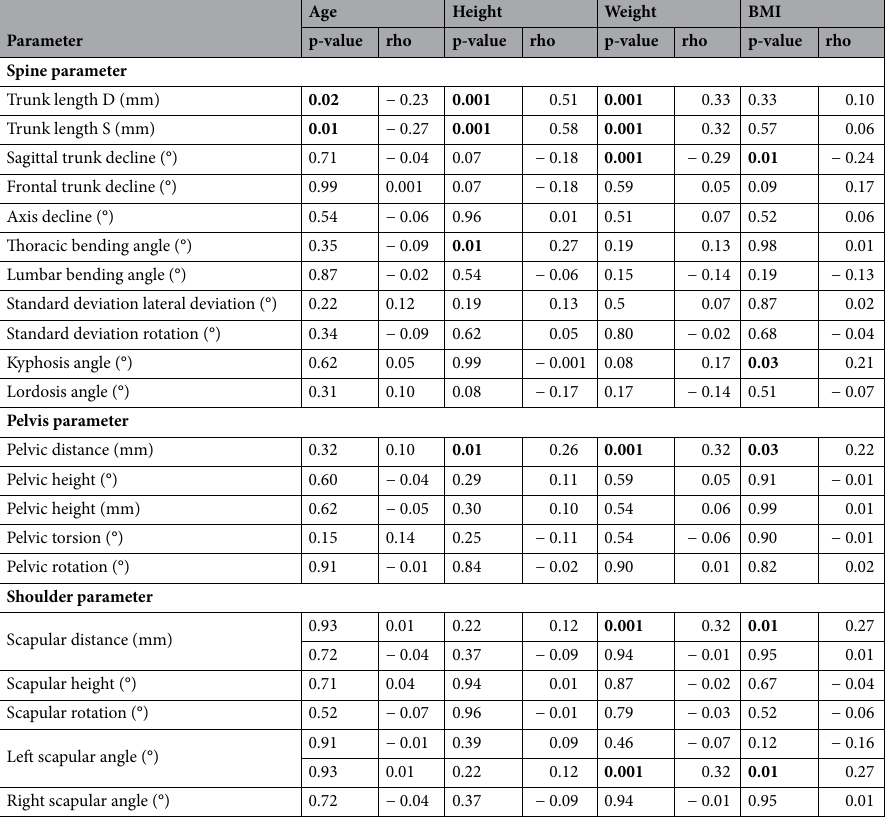
Table 2. Presentation of the p-values with associated correlation coefficients. Correlation coefficients are according to Evans [rho < 0.2 very weak, rho = 0.2–0.4 weak, rho = 0.4–0.6 moderate, rho = 0.6–0.8 strong, rho > 0.8 optimal] when comparing the back parameters to the parameters of age, height, weight and BMI. Significant p-values are printed in